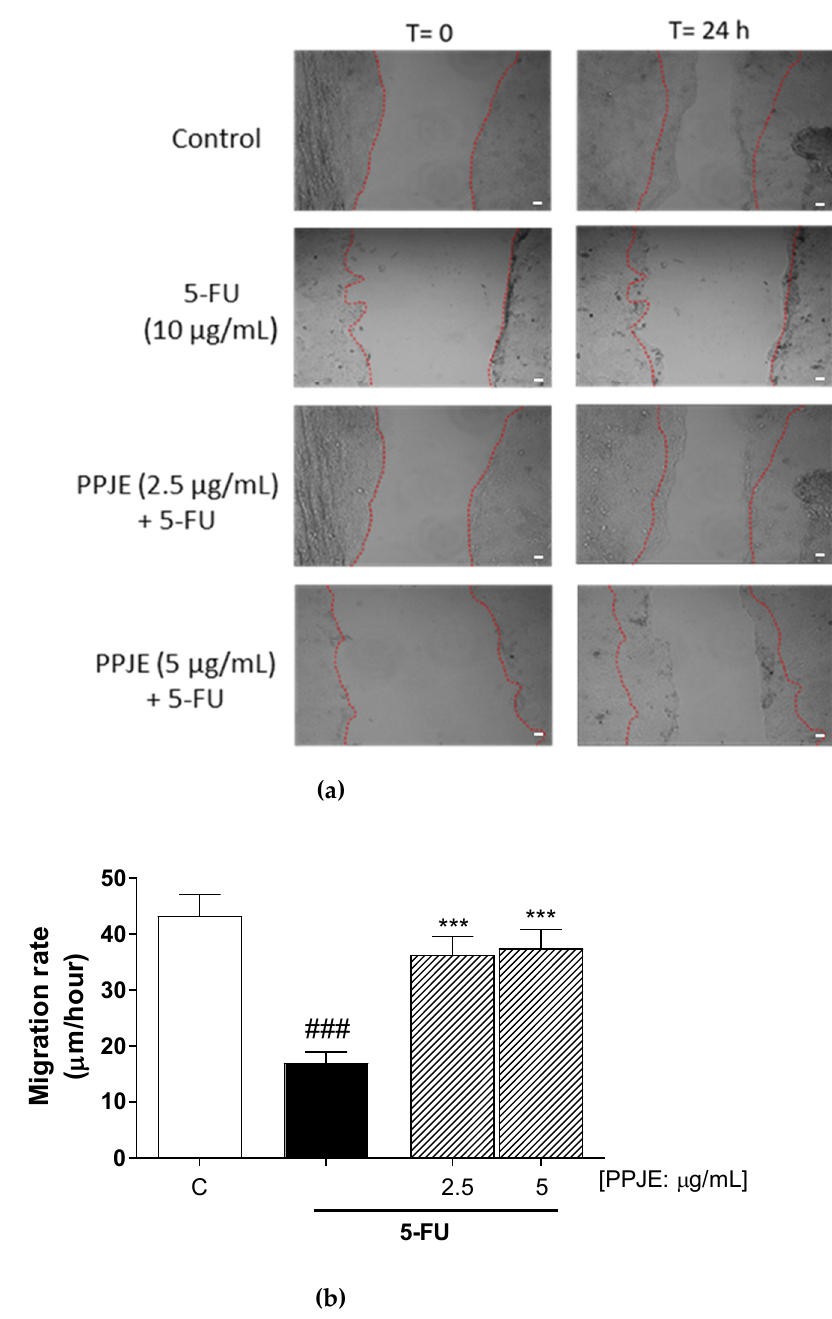
Figure 6. Effect of PPJE (2.5–5 µg/mL) on wound repair after a mechanical scratch in HaCaT cells treated with 5-fluorouracil. FU; 10 µg/mL); Bar = 150 µm ( a ), and the quantitative analysis expressed as HaCaT migration rate after 24 h ( b ). C denotes control group; ### denotes p < 0.001 vs. C; *** denotes p < 0.001 vs. 5-FU.